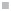
Fosmidomycin accumulation in E. coli.E. coli was treated with 110 μM (20 μg/mL) or 550 μM (100 μg/mL) fosmidomycin in CAMHB (■) or M9-glucose (■) medium. Intracellular fosmidomycin accumulation was monitored by LC-MS (SRM method). Fosmidomycin uptake is robust and dose-dependent in CAMHB medium, and poor in M9-glucose medium. (n = 3, error bars are standard error, p-values above charts were calculated using an unpaired, 2-sample t-test).